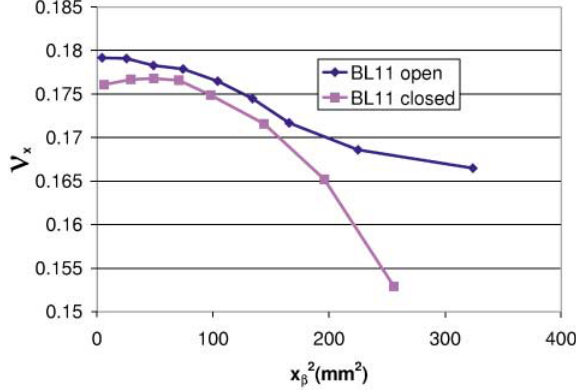
FIG. 12. (Color) Tune vs betatron oscillation amplitude with magic fingers.